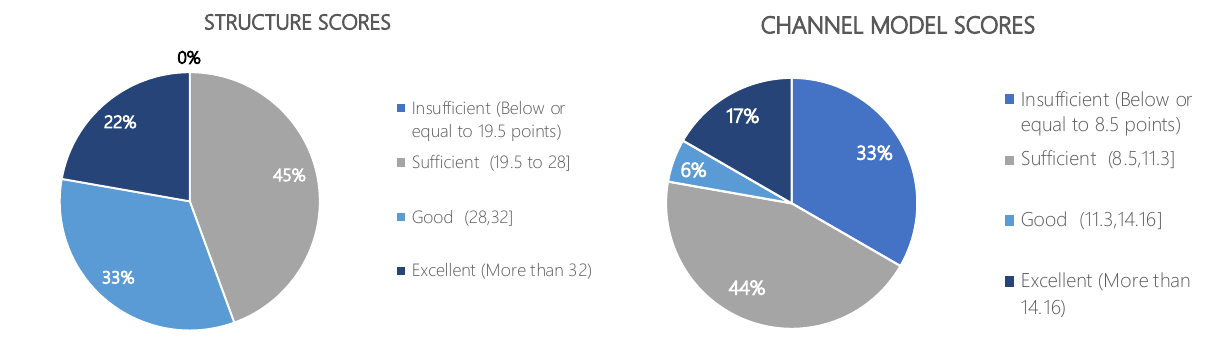
Figure 21. Structure and Channel Model Scores.